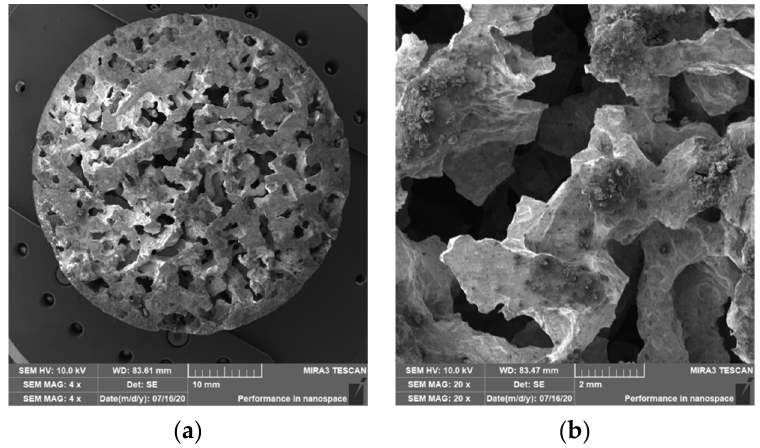
Figure 13. View of the structure of the porous material of AlSi12 alloy: ( a ) detail of the material; ( b ) scanning electron microscope image (Vega 3 Tescan, SEM HV 20.0 kV) of sample SAM4.